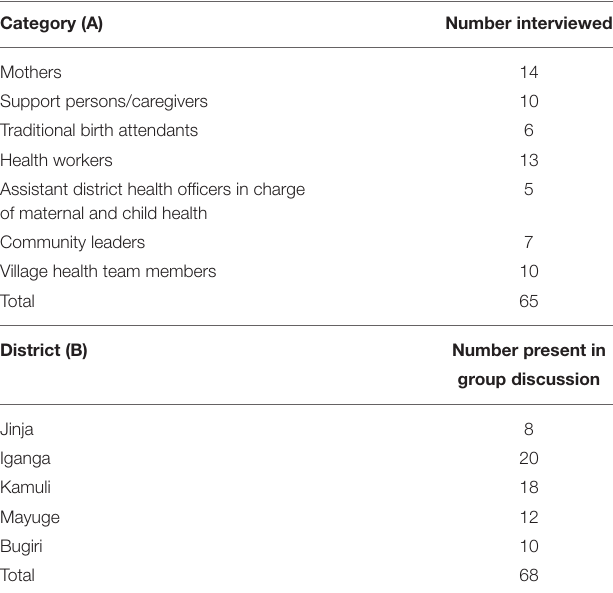
TABLE 2 | Number of interviews and